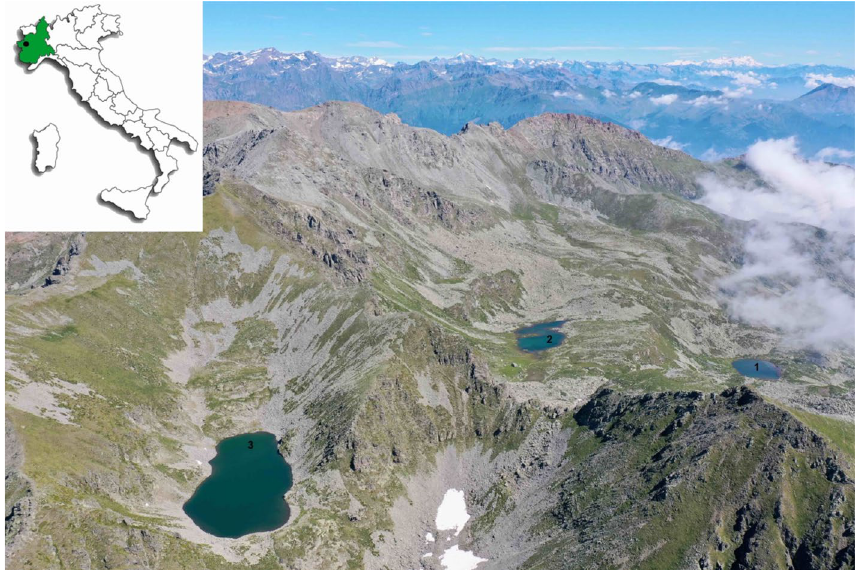
Figure 3. Location of fish sampling sites in the Cottian Alps (northwest Italy): (1) Lower Balma Lake, (2) Upper Balma Lake, and (3) Rouen Lake (drone photo: Paolo Pastorino).